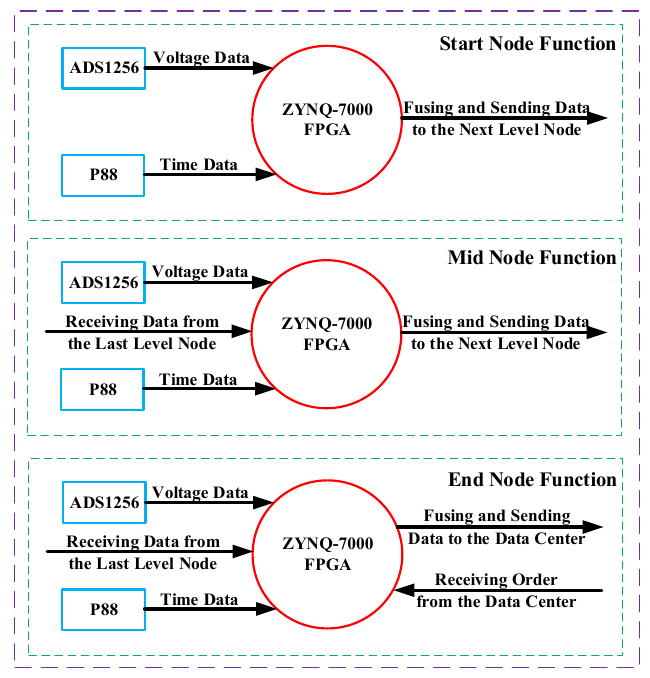
Figure 2. Function diagram of different types of nodes.